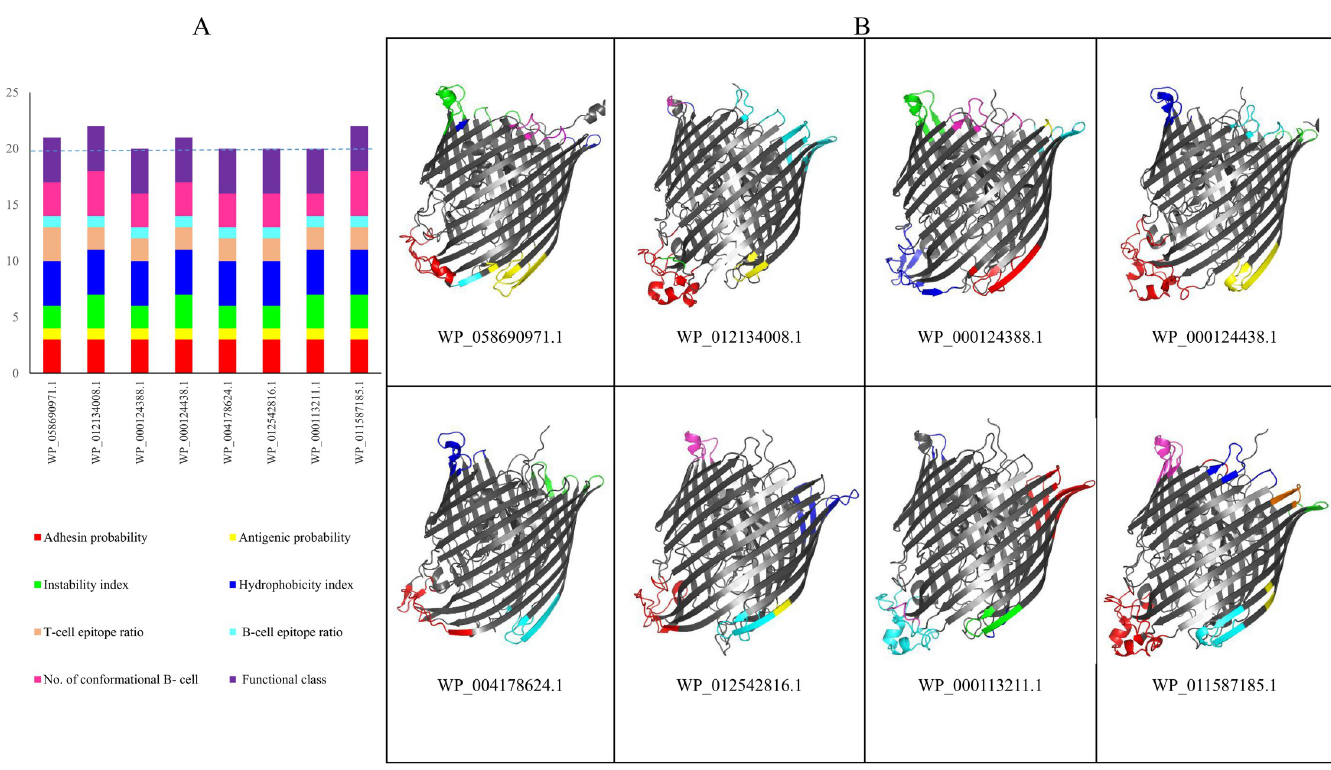
Fig 7. A. The comparison of eight proteins belonging to ferrichrome outer membrane transporter conserved superfamily in eight clinically important genera of Enterobacteriaceae . All selected proteins scored � 20 based on the quartile method with physicochemical properties, functional class, number of linear and conformational B/T-cell epitopes similar to our candidate, TonB-dependent siderophore receptor (WP_058690971.1). B. The tertiary structure and conformational B- cell epitopes of ferrichrome porins in major clinically important genera of Enterobacteriaceae family.